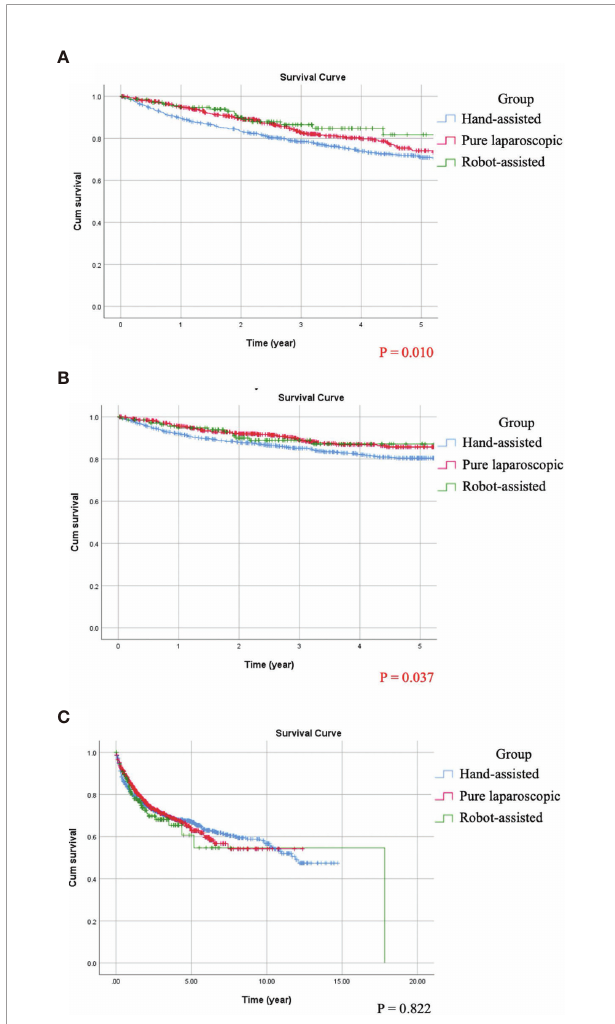
FIGURE 1 | Compare Kaplan-Meier curves between patients receiving different minimally invasive nephroureterectomy by log-rank test. (A) Overall survival, p = 0.010. (B) Cancer-speci fi c survival, p = 0.037. (C) Bladder recurrence-free survival, p =